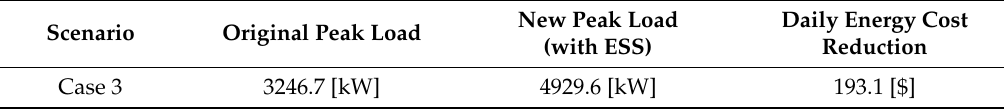
Table 11. Summary of Case 3 simulation results.